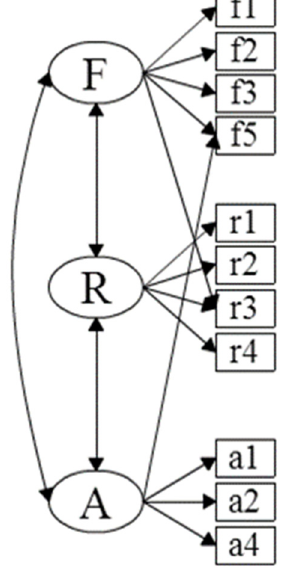
Figure 2. Model 2 or improved model.